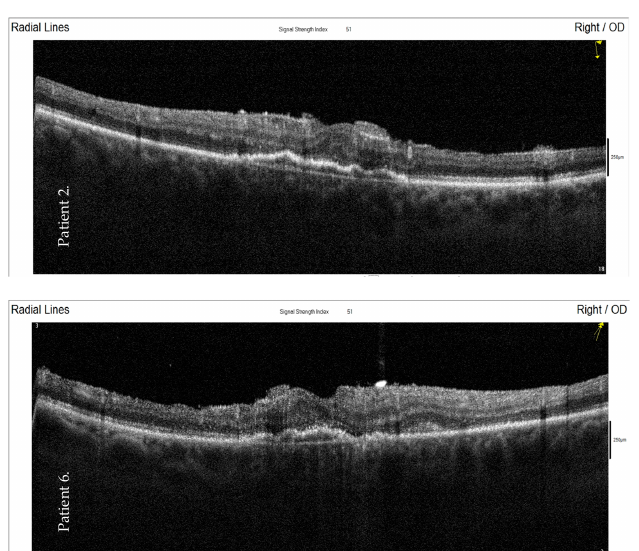
Figure 3. Optical coherence tomography (OCT) images—the final examination of two patients (numbers 2 and 6) four months after the post-injection endophthalmitis and emergency pars plana vitrectomy. The OCT scans show a disruption of the inner retinal layers, an irregular line of the retinal pigment epithelium, and no intraretinal fluid. OD: oculi dextri.